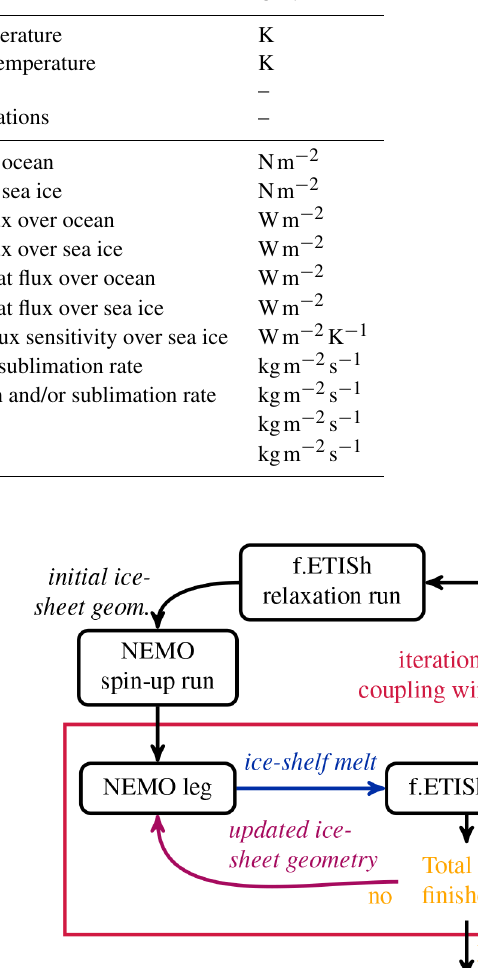
Figure 2. COSMO–NEMO coupling interface diagram for two cou- pling windows. Full blue (black) arrows correspond to exchange of tile-specific (non-tiled) fields. The thick dashed vertical line delim- its the transition from one coupling window to the next one. NEMO sends tile-specific surface properties to the COSMO surface mod- ule, which are used to compute tile-specific fluxes. These fluxes are then (i) sent back to NEMO on the next coupling window (hence NEMO getting delayed fluxes); (ii) pseudo-averaged to be injected into the COSMO dynamics. In addition, non-tiled fluxes (e.g., pre- cipitation) are also sent from COSMO to NEMO. For the sake of readability, the incoming (outgoing) fluxes from coupling window n − 1 (to coupling window n + 2) are not represented.